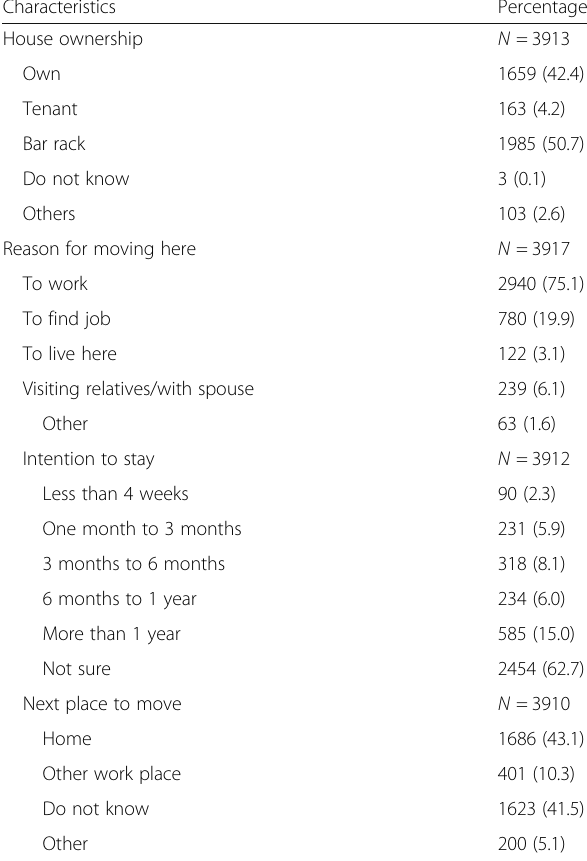
Table 2 Characteristics and migration dynamics of